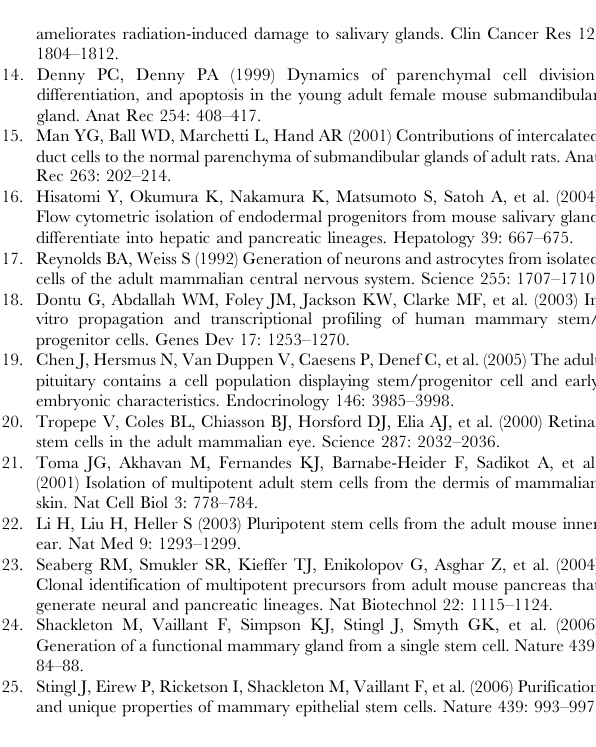
Figure S3 GENOTYPING SECONDARY SPHERES. Aga- rose gel showing nested-PCR products of spheres cultured from transplanted recipients contain cells with donor Y-chromosome marker. PCR on the X-chromosome and the GAPDH gene was used to verify DNA loading. Found at: doi:10.1371/journal.pone.0002063.s003 (1.50 MB DOC) Figure S4 HUMAN SALIVARY GLANDS CONTAIN C- KIT + CELLS AND CAN YIELD SPHERES. (A–E) Dissociated human submandibular and parotid (F) glands form spheres. Initially these cells lacked mucins (PAS 2 ) (G,H), but they differentiate in time into mucin expressing cells (I,J, PAS + ). Normal human submandibular glands (K,L) contain mucous PAS + and serous cells, whereas normal human parotid gland contain serous acini (M,N). (O) Irradiated human submandibular gland lose acinar cells very similar to the mouse. Both human submandibular (P) and parotid (Q) glands express c-Kit exclusively in duct cells. D =ductal cell type, AC= acinar cell, D0–3–5–10 represent days in culture. Scale bar= 50 m m, inset =20 m m. Found at: doi:10.1371/journal.pone.0002063.s004 (9.12 MB